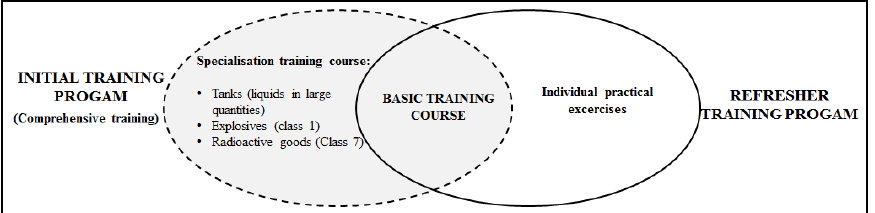
Fig. 2. The content of ADR driver training programs. Source: [18]; adapted by